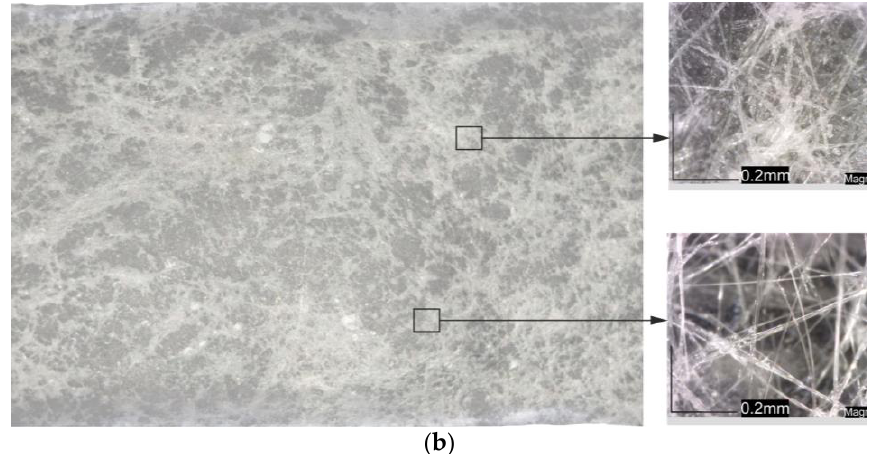
Figure 2. ( a ) A 3D-printed core (during printing process) and assembly of sandwich structures, ( b ) top view and optical microscopy of starch-based film (with 20 wt% glycerol, 3 wt% NaMMT, 10 wt% cellulose and fiberglass fabric).